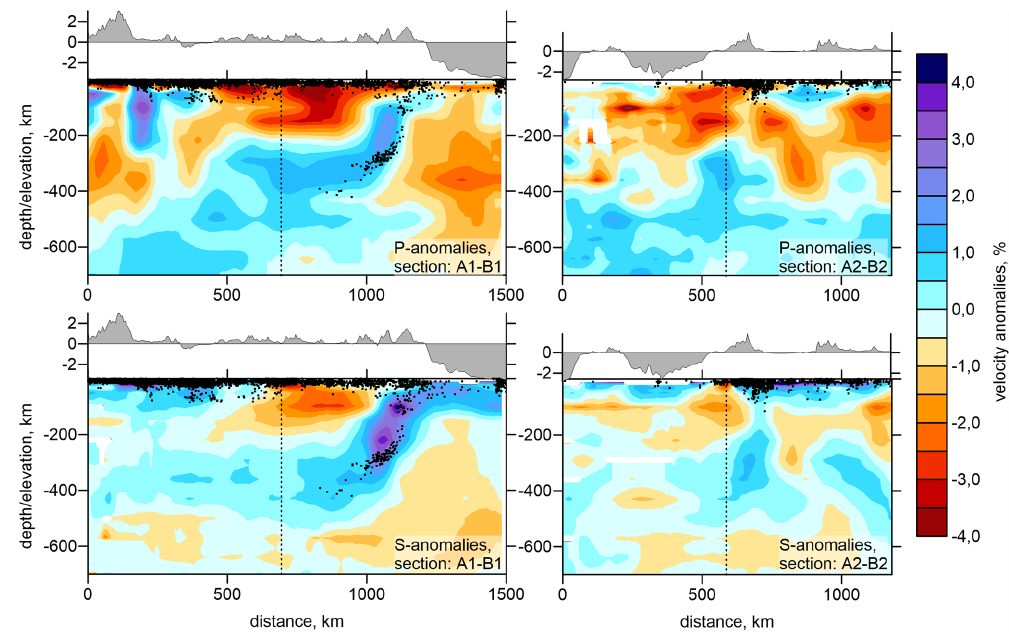
Figure 4. P and S velocity anomalies in vertical sections. Locations of the profiles are shown in Fig. 3. Dots indicate projections of the earthquakes located at distances of less than 50km from the profile. Exaggerated relief along the profiles is presented above each plot. Dotted line indicates the intersection with another